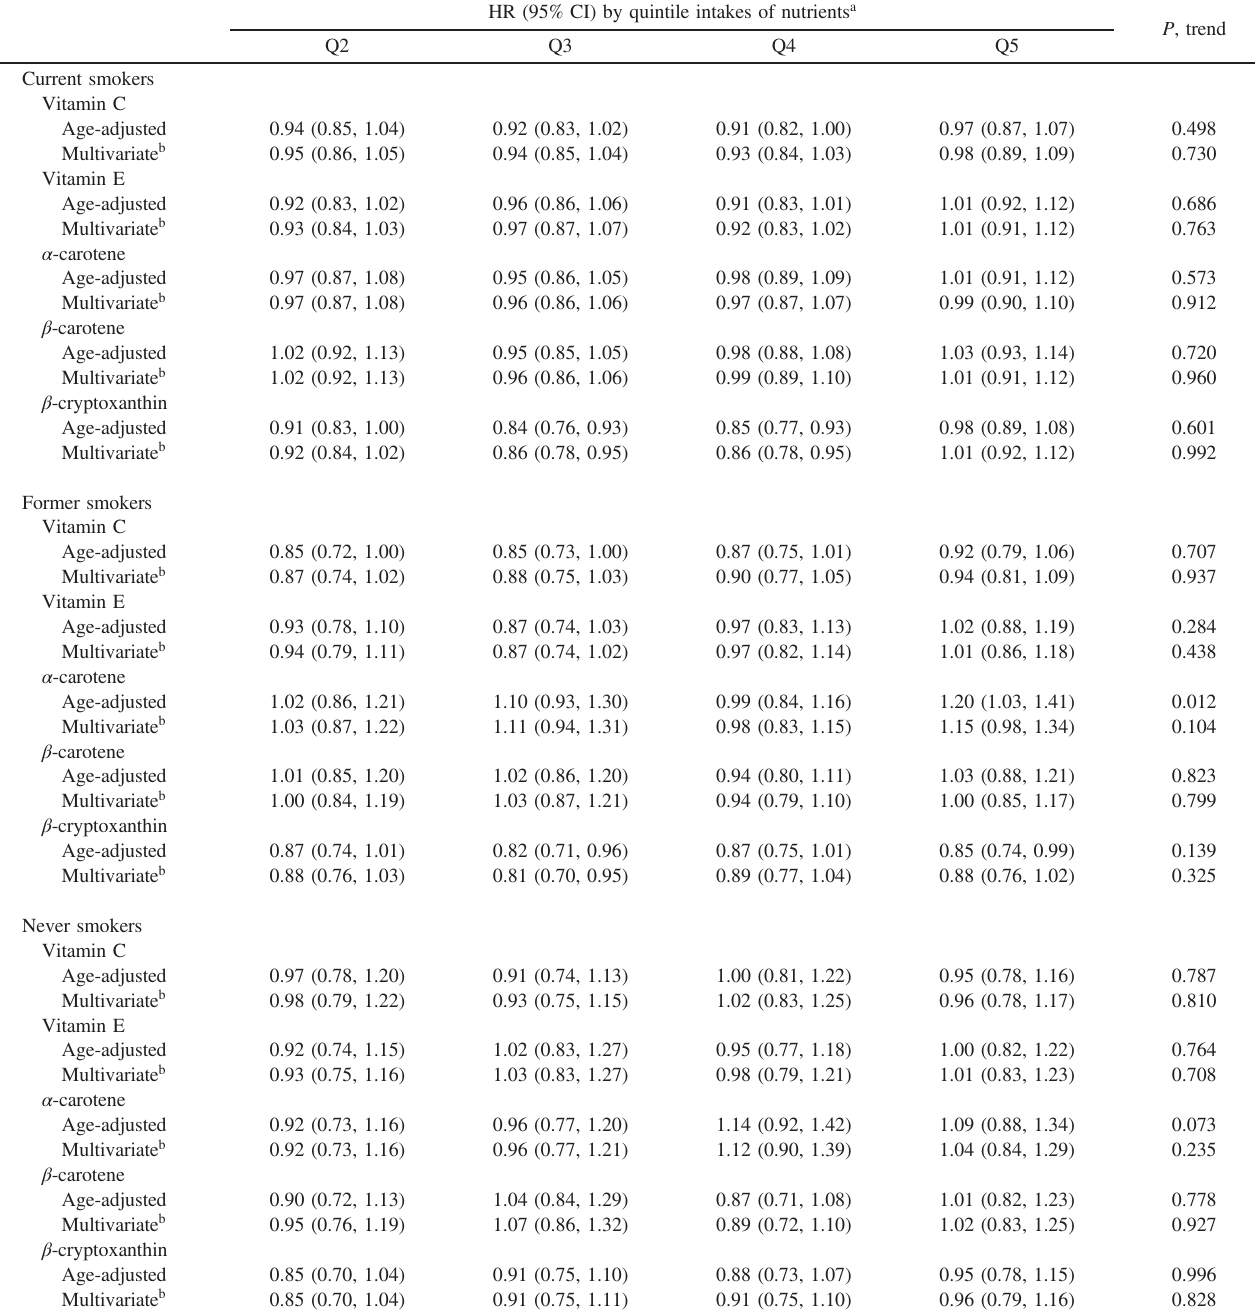
Table 4. Associations between energy-adjusted dietary antioxidant nutrients and all-cause mortality in men of current, former and never smokers, JACC